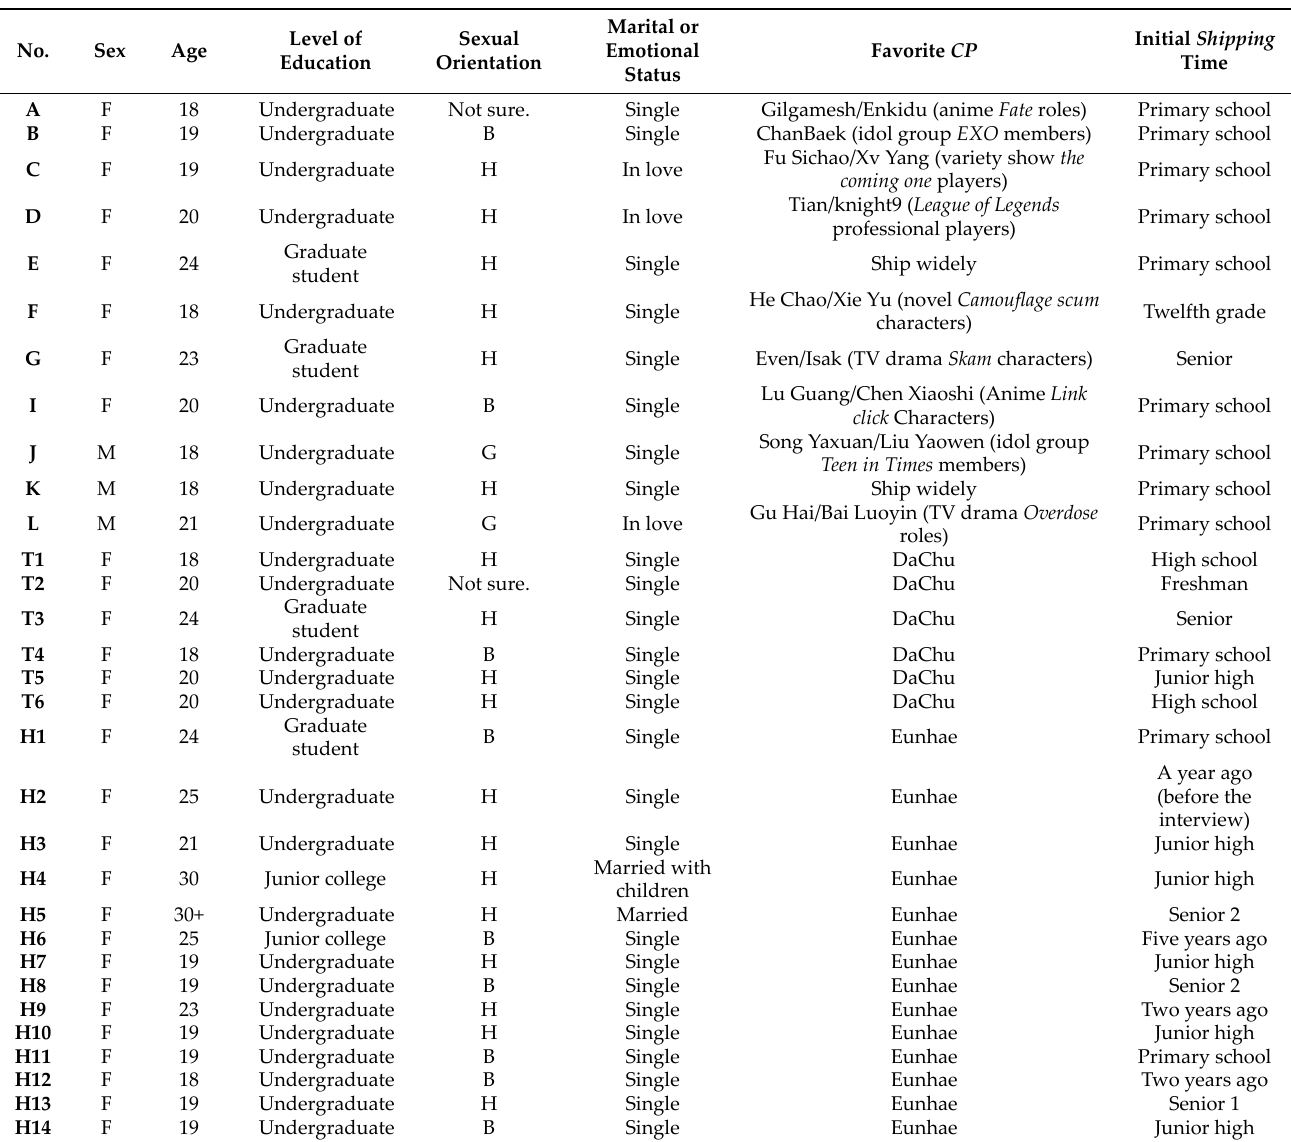
Table 1. Basic information of